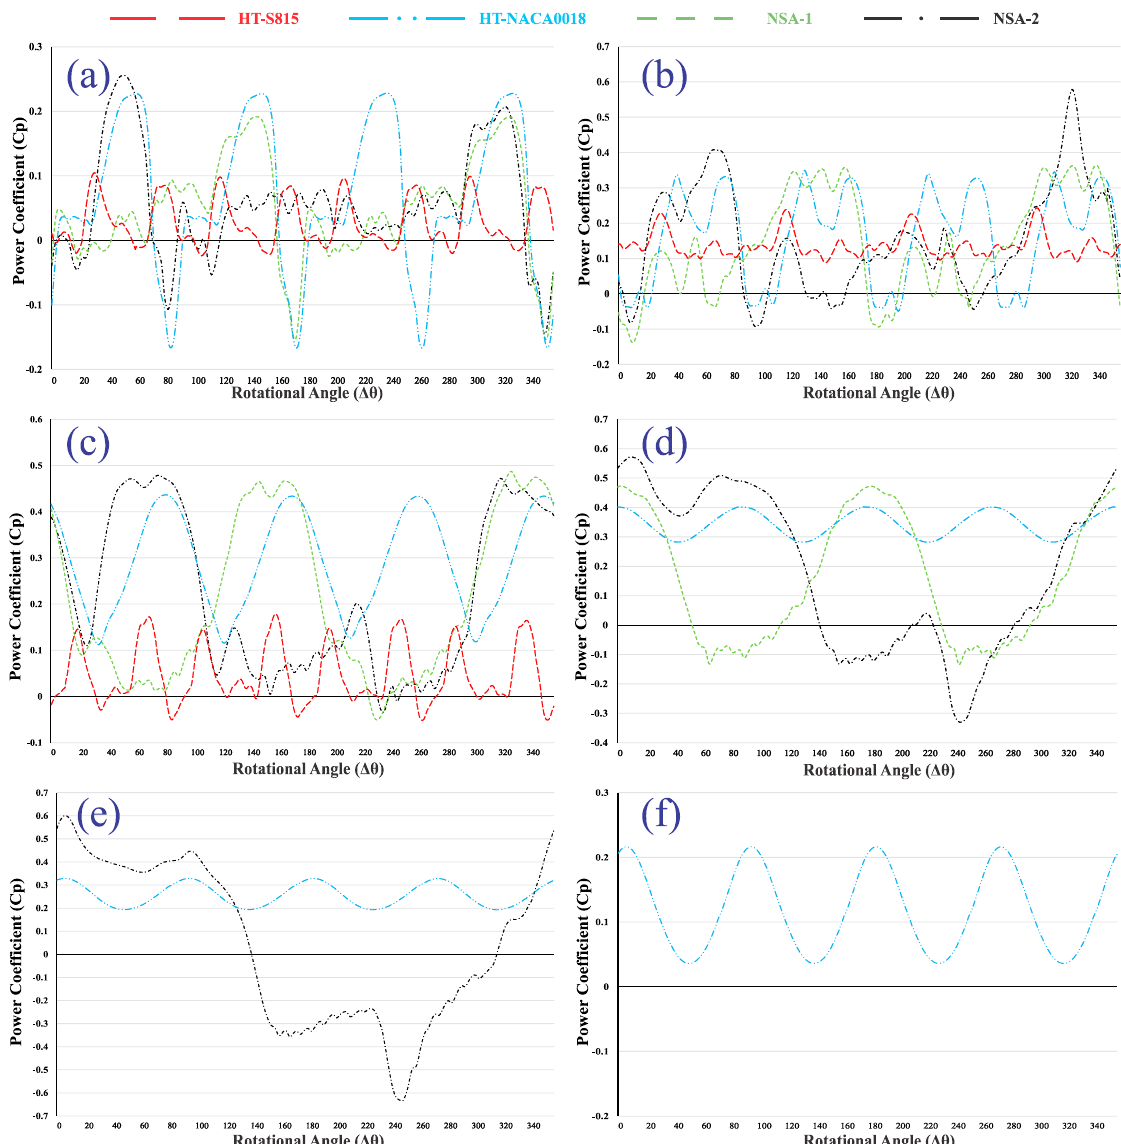
Figure 6. Power coefficient of VAWTs with TSRs of ( a ) 1.5, ( b ) 2, ( c ) 2.5, ( d ) 3, ( e ) 3.5, and ( f ) 4; for zero azimuth angle ( θ = 0°), see Figure 1.